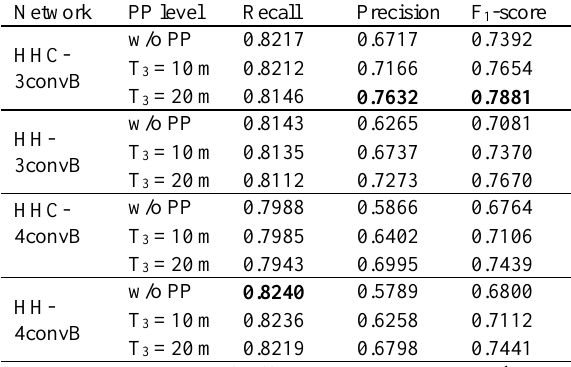
Table 2. Testing results of different CNN architectures (w/o PP: without post-processing).